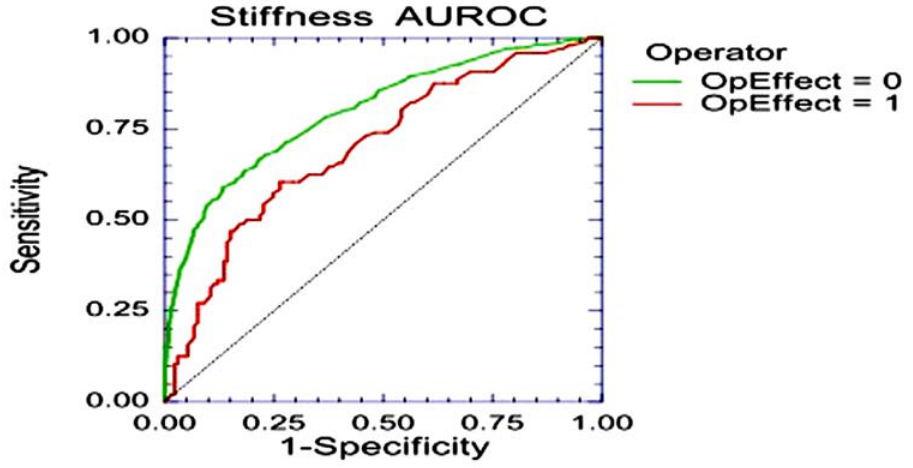
Figure 1. Operator effect. One operator has significantly lower concordance between stiffness measurement and FibroTest than the other operator (area under the ROC curve=0.70; 95%CI 0.63–0.76, versus 0.80; 95%CI 0.77–0.82;